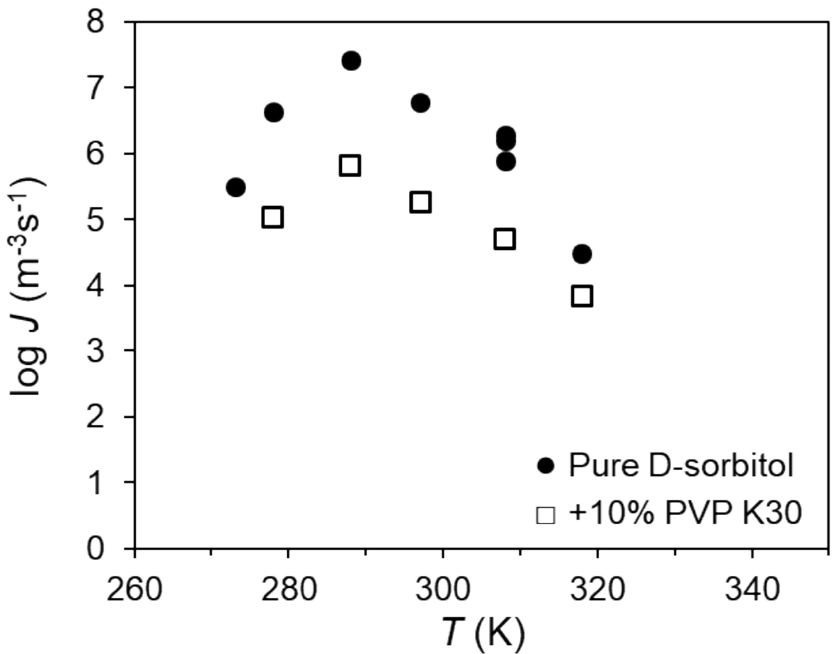
Figure 2. Effect of 10 wt% PVP K30 on the rate of nucleation of D-sorbitol. The solid circle and hollow square respectively represent the nucleation rates of pure D-sorbitol and PVP-doped system measured using two-stage method. Adapted from Ref. [26] with permission. Copyright © 2019 American Chemical Society.